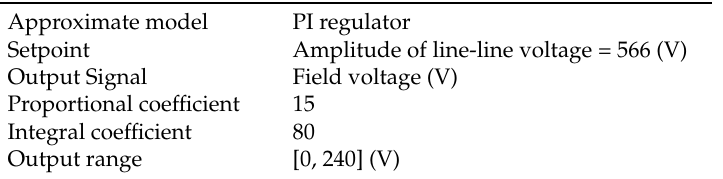
Table 4. Parameters of the excitation system for the SG.